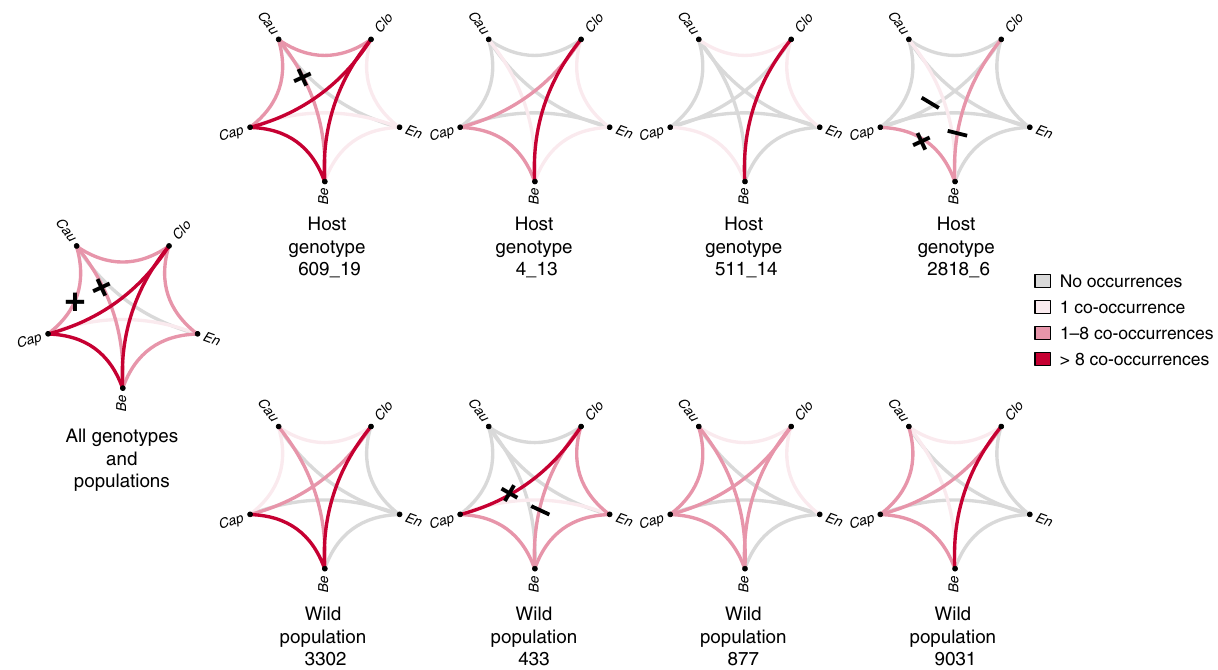
Fig. 3 Co-occurrences between virus species. Co-occurrences are shown either in the whole data set (left, with total number of sentinel plants 320), or per plant genotype (upper panels, 80 plants per genotype), or by population (lower panels, 80 plants per population) as denoted by the horizontal axis. The genotypes and populations are ordered from left to right according to decreasing the overall frequency of disease. The plus (and minus) signs denote the pairs, for which the observed values were higher (or lower, respectively) than what would be expected based on their overall frequencies, and for which the probability of this difference was <0.1. The line colours denote the true numbers of co-occurrences between the species, as shown in the legend. ‘ Clo ’ refers to Plantago closterovirus , ‘ Be ’ to Plantago betapartitivirus , ‘ Cap ’ to Plantago lanceolate latent virus , ‘ Cau ’ to Plantago latent caulimovirus , and ‘ En ’ refers to Plantago enamovirus . The exact probabilities for the focal pairs are provided in the Supplementary Table 3. Table 1 Joint species distribution model variants and their explanatory performance and predictive performance (based on cross-validation), measured by the Tjur R 2 coef fi cient of determination 110 (see ‘ Methods ’ and Supplementary